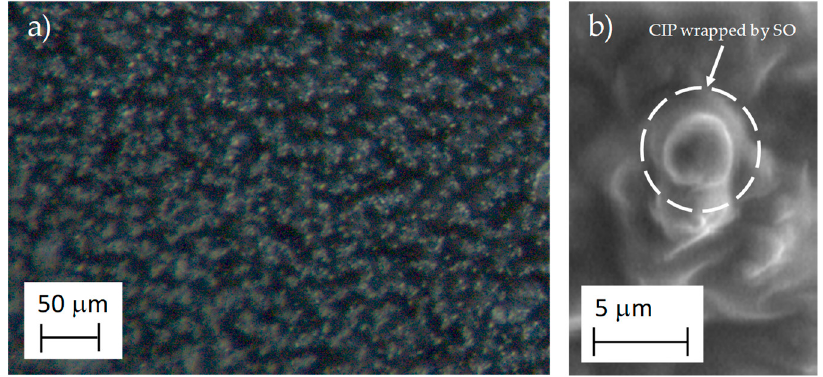
Figure 9. Particle dispersion in the elastomer with 45 wt % of CIPs: ( a ) homogenous CIPs distribution, and ( b ) image that shows a CIP wrapped in the PDMS matrix.